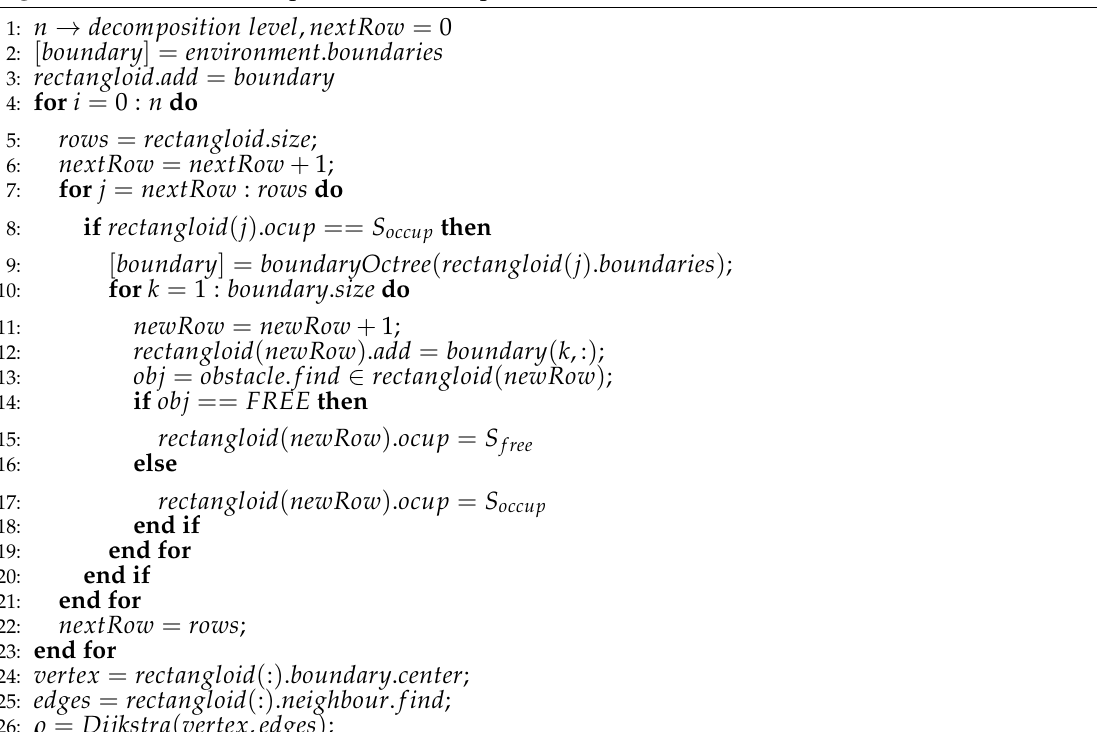
Algorithm 1 Modified Adaptive Cell Decomposition ( MACD